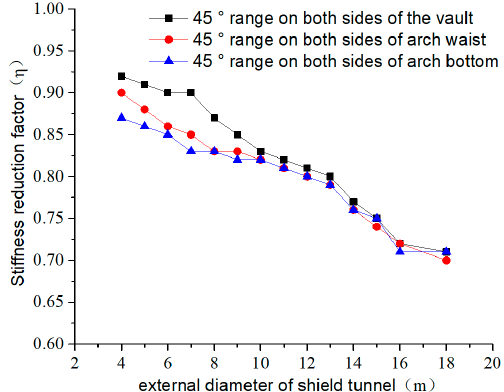
Table 2. The relationship between measured value of internal segment force and calculation value of software.